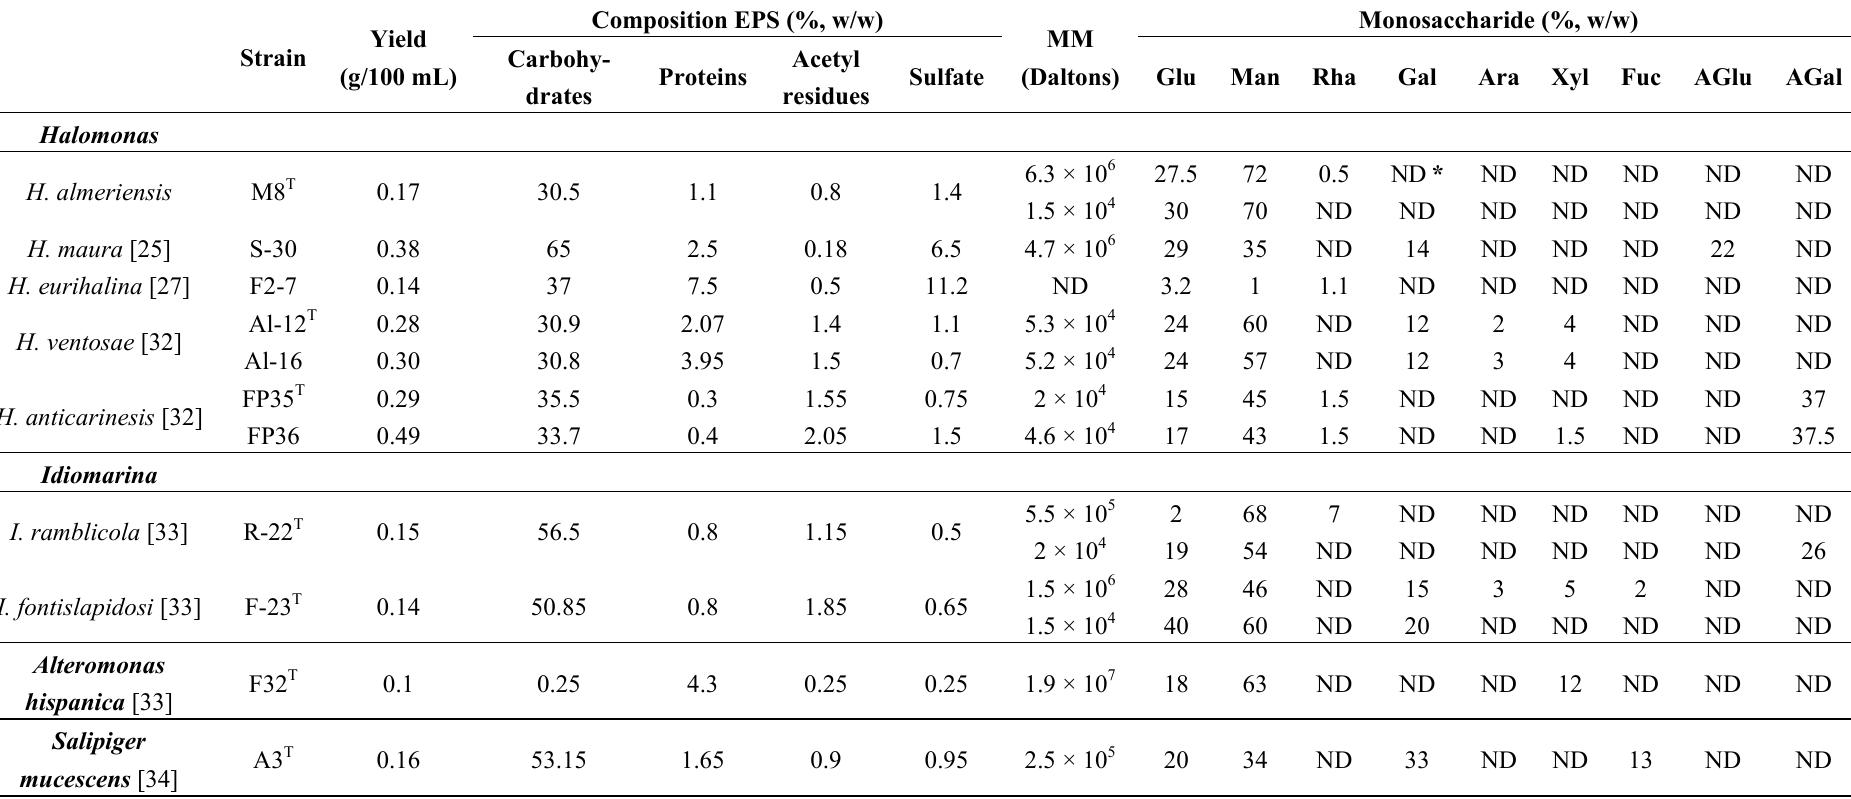
Table 3. Characteristics of exopolysacharides produced by halophilic